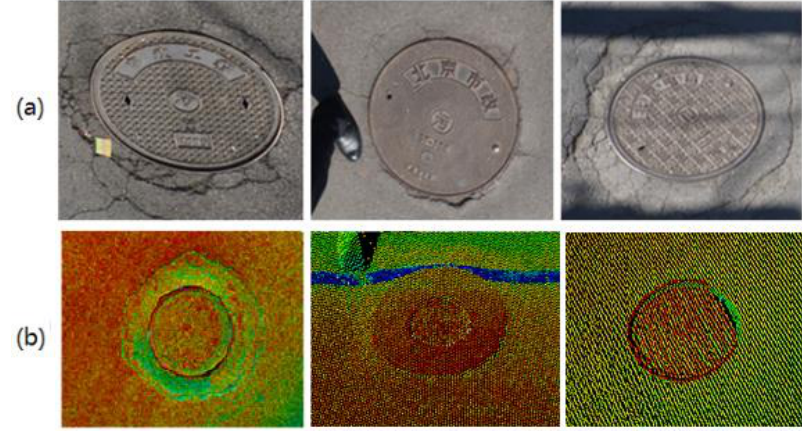
Figure 4. Example manhole-cover images. ( a ) Ground images. ( b ) Laser data images.